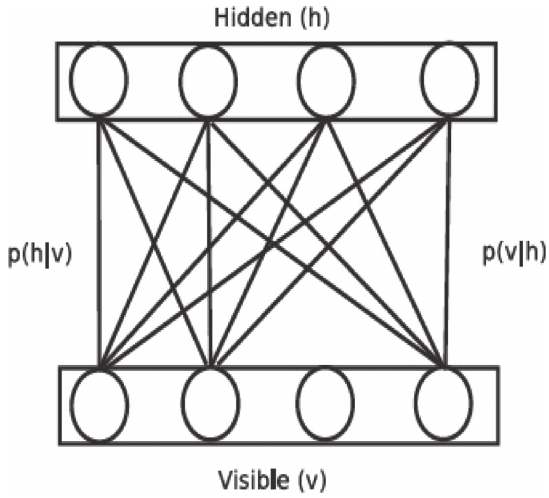
Figure 8: Block Diagram of Restricted Boltzmann Machine.